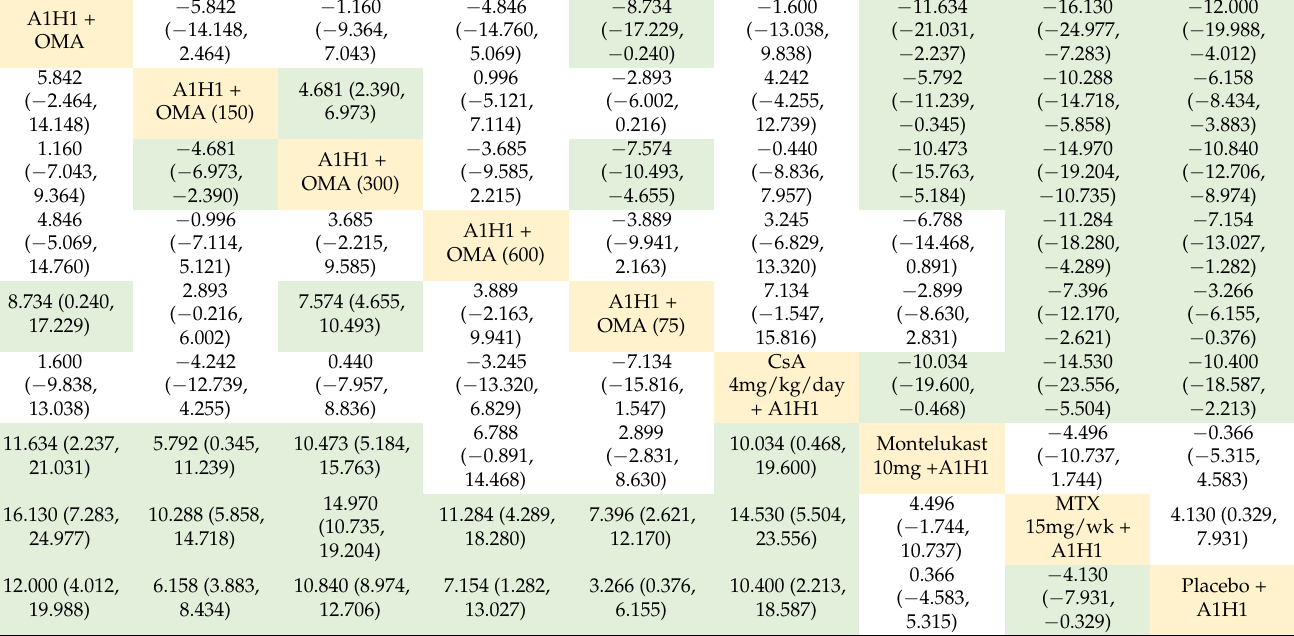
Table 3. League table of the weekly urticaria activity scale (UAS7) assessment.